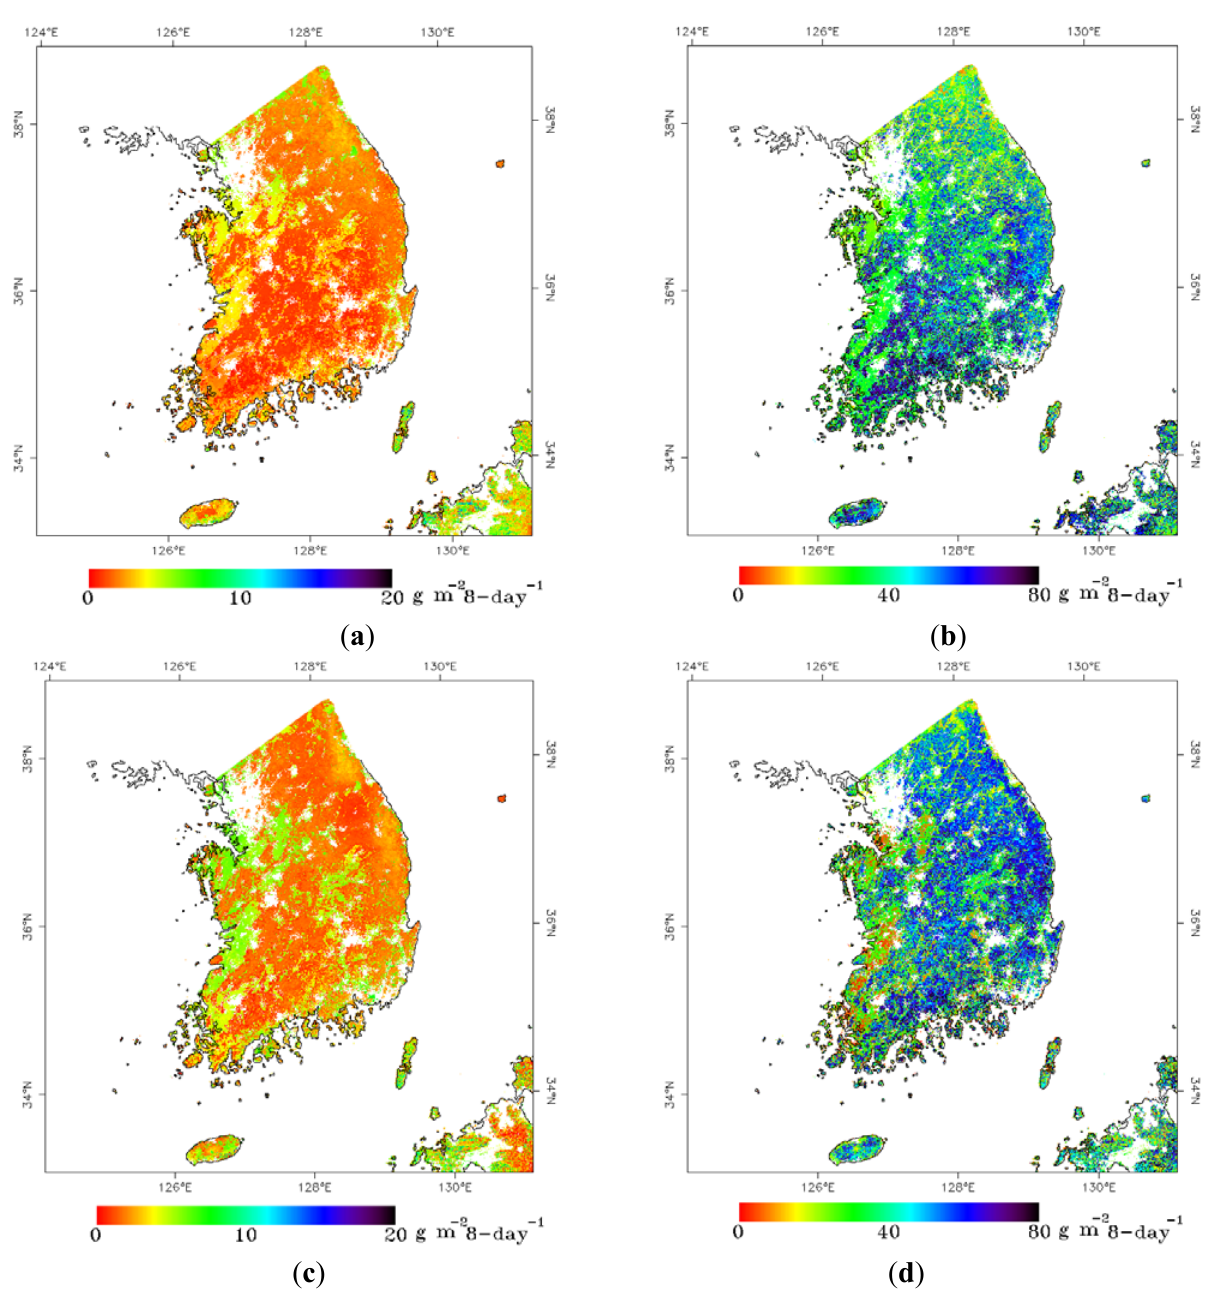
Figure 9. Spatial distribution of ET in South Korea. ( a ) 17–24 January 2007. ( b )